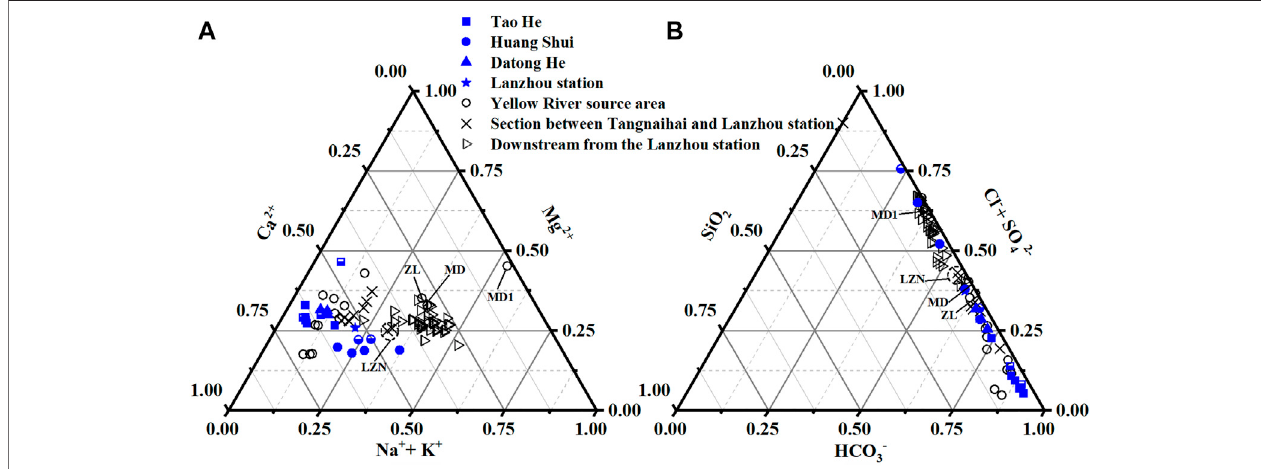
FIGURE 3 | Ternary plots of the (A) major cations and (B) anions-silica for the Tao He, Huang Shui, and Datong He (blue symbols) and the Lanzhou station on the YellowRivermainstream(bluestars)insummer(in μ Equnits).Thesolidbluesymbolsrepresentdatacollectedinthisstudy,andthehalf- fi lledbluesymbolsrepresentdata fromWuetal.(2005).TheblacksymbolsaredatafromtheYellowRivermainstreamobtainedfromWuetal.(2005),Fanetal.(2014),andWangetal.(2016).Thesymbols marked in the fi gure are MD 1 (Maduo1), ZL (Lake Zaling), and MD (Maduo) are all located in the source area of the Yellow River in the Maduo territory. Because of thin-bedded halite deposits (Zheng, 1997), the proportion of Na + + K + is extremely high. In addition, data reported by Wu et al. (2005) were collected at the Lanzhou station during thenon- fl oodseason(LZN) inMay and June,whichcausedexceedinglyhigher proportions ofNa + +K + and Cl − +SO 42 − .However,otherdatain Figure3 were collected during the fl ood season in July and/or August.